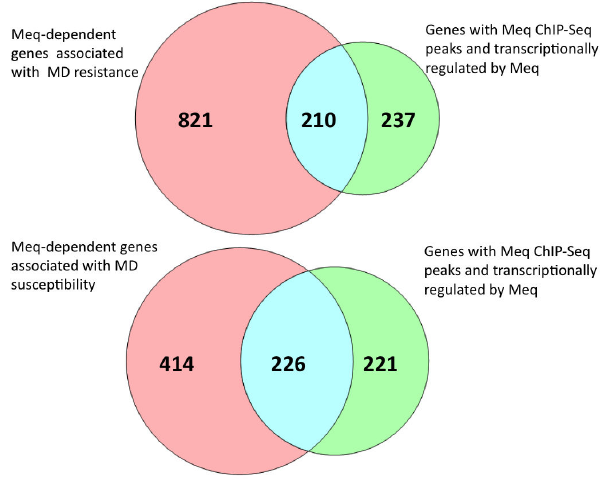
Figure 4. Meq-dependent genes identified through integrated analysis. Representation of overlap between Meq- dependent genes involved in MD resistance and genes with Meq ChIP-Seq peaks and transcriptionally regulated by Meq. doi: